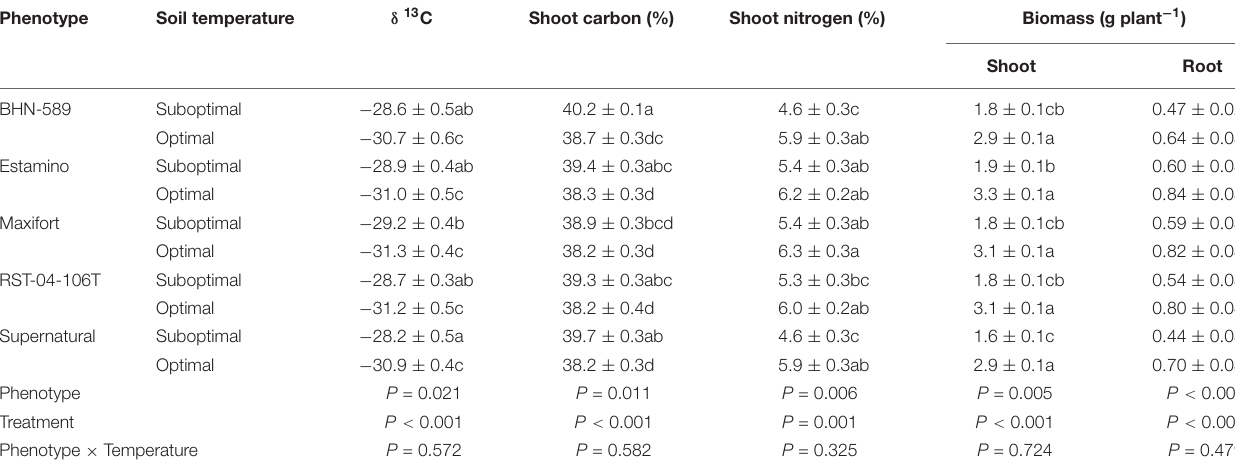
TABLE 3 | Leaf δ 13 C, shoot percent carbon, shoot percent nitrogen, shoot biomass, and root biomass of four grafted rootstocks (Estamino, Maxifort, RST-04-106-T, and Supernatural) and one cultivar (BHN-589) exposed to optimal and suboptimal soil temperatures for 4 weeks.